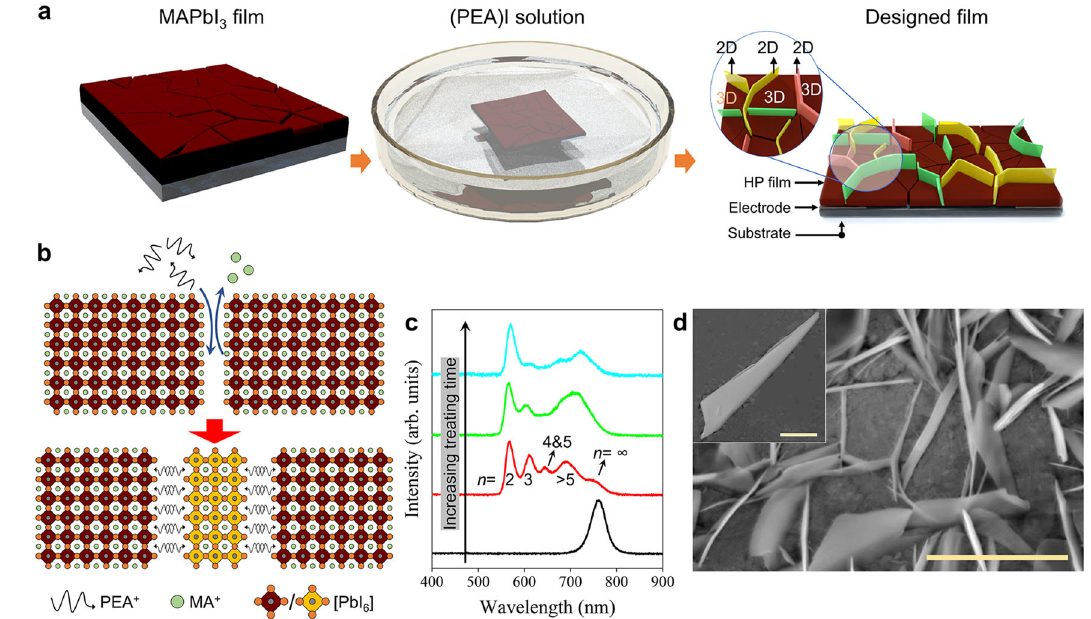
Fig. 1 | Isolating 3D HP grains by 2D HP platelets. a Schematic diagram of the experimental fabrication process of the GIHP fi lm. b Schematic illustration of the cation exchange-induced growth of 2D HP at the boundaries of 3D HP